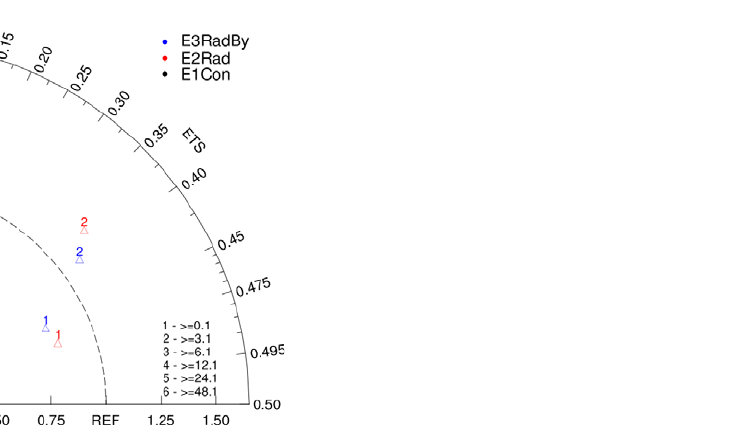
Figure 17. Taylor diagrams of the six hours accumulated precipitation forecast at 1800 UTC from 1 July to 31 July 2019.